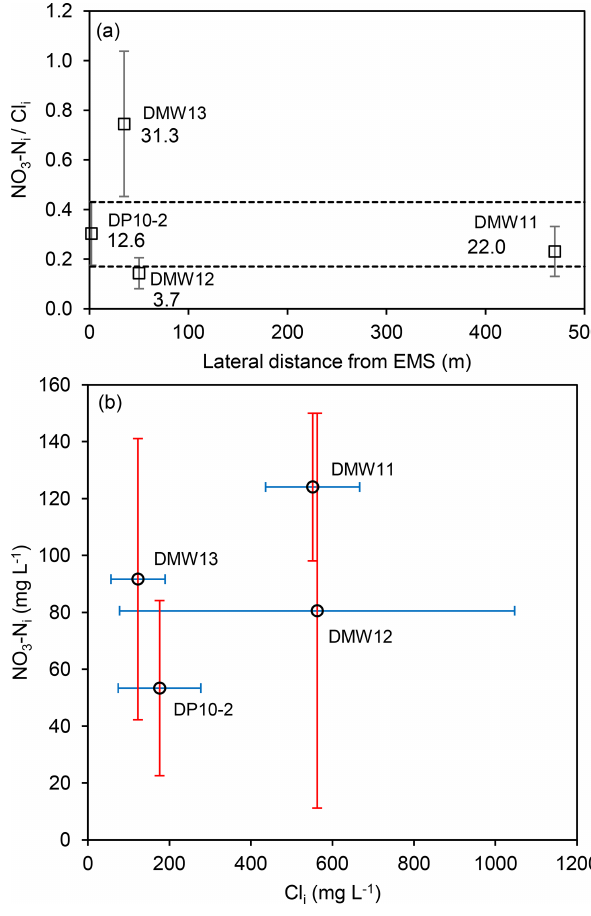
Figure 4. (a) Estimated NO 3 − N i / Cl i ratios (mean and SD) in wa- ter table wells with evidence of denitrification at CFO1, plotted with distance from earthen manure storage (EMS), where dashed lines are the upper and lower bounds of DP10-2 (EMS source) and la- belled values are maximum measured NO 3 − N (mgL − 1 ) . (b) Es- timated concentrations of NO 3 − N i and Cl i at CFO1 (mid-range, error bars are max and min